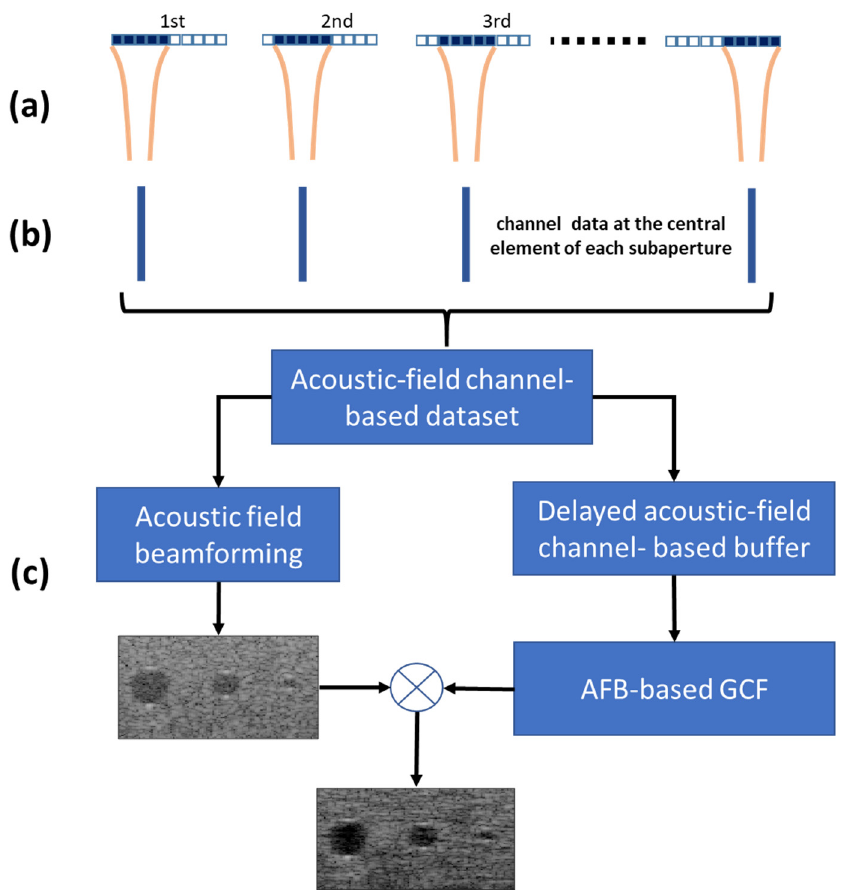
Figure 1. Schematic of the acoustic field beamforming (AFB)-based generalized coherence factor (GCF) method. ( a ) Repeat transmit pattern through the array. ( b ) Compose an acoustic-field channel-based data set. ( c ) The system block diagram for the AFB-based GCF technique.